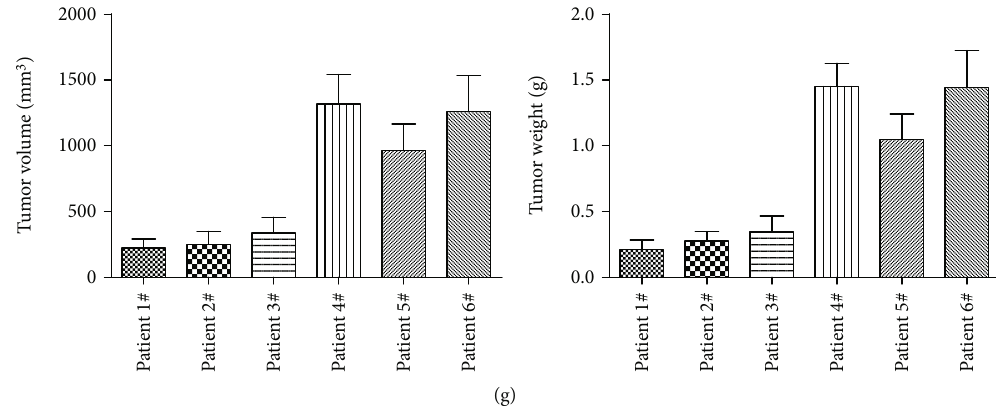
Figure 5: miR-28-5p knockdown HCC cells are more sensitive to sorafenib treatment. (a) The expression of miR-28-5p in sorafenib-resistant HCC xenografts was determined by RT-PCR assay ( n = 3 ). (b) The expression of miR-28-5p in sorafenib-resistant HCC cells and control cells was determined by RT-PCR assay ( n = 3 ). (c) The miR-29-5p mimic and control HCC cells were treated with sorafenib (10 μ M) for 48 hours and subjected to fl ow cytometry assay ( n = 3 ). (d) The miR-29-5p sponge and control HCC cells were treated with sorafenib (10 μ M) for 48 hours and subjected to fl ow cytometry assay ( n = 3 ). (e) The miR-29-5p mimic and control HCC cells were treated with sorafenib (10 μ M) for 48 hours and subjected to western blot assay. GAPDH acted as a loading control. (f) The expression of miR-28-5p in PDX primary tumors was determined by RT-PCR assay. (g) PDXs with low or high miR-28-5p levels in their primary tumors were treated with sorafenib (60 mg/kg body weight) or vehicle for 30 days ( n = 5 for each group). The terminal tumor size and weight was showed. Data are represented as mean ± s : d : ; ∗ P < 0 : 05 ; two-tailed Student ’ s t